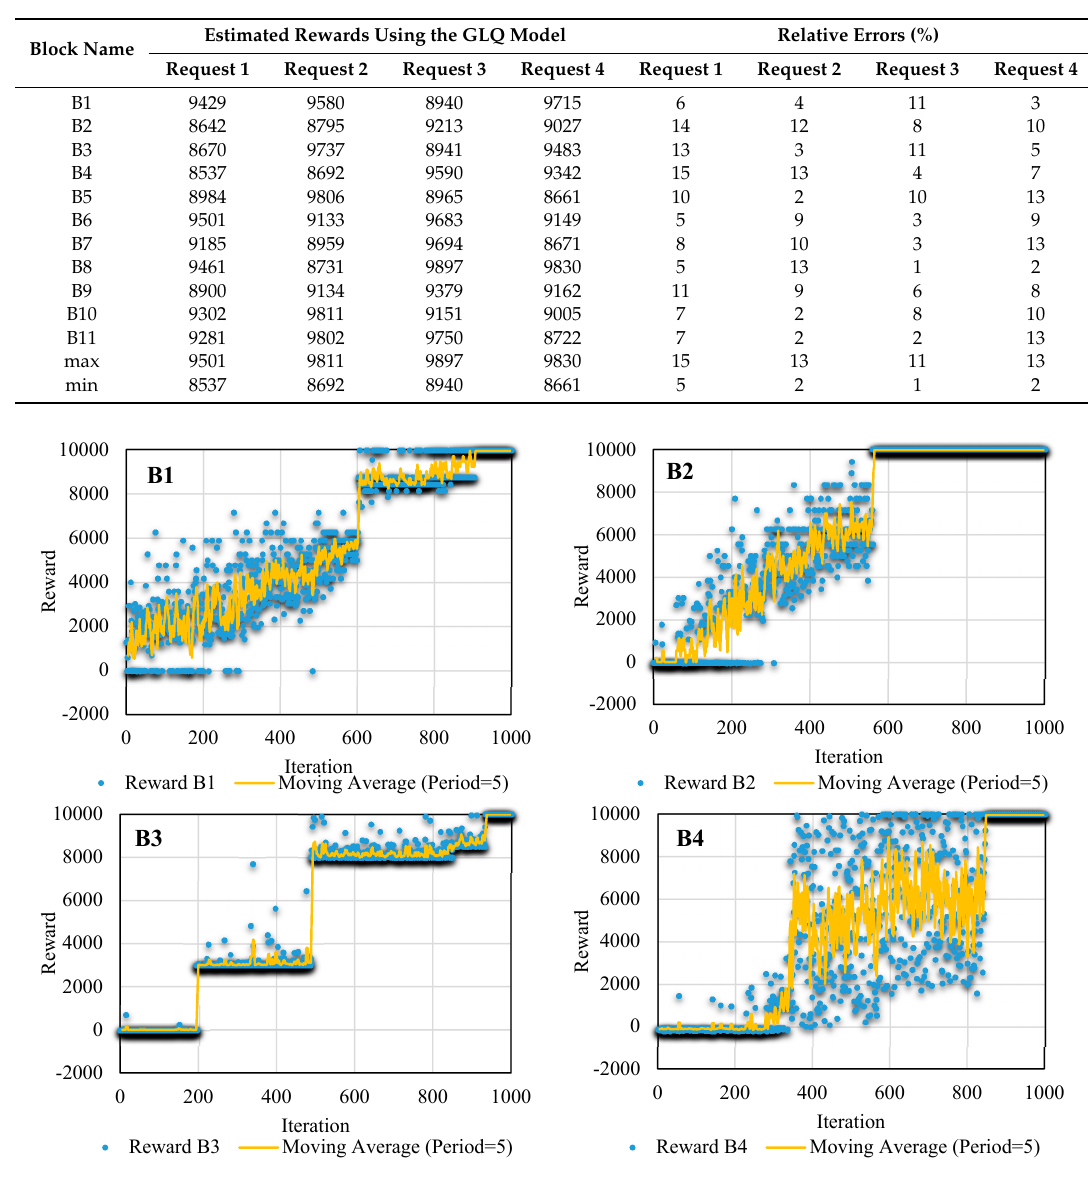
Table 4. Assigned rewards of water requests and corresponding relative